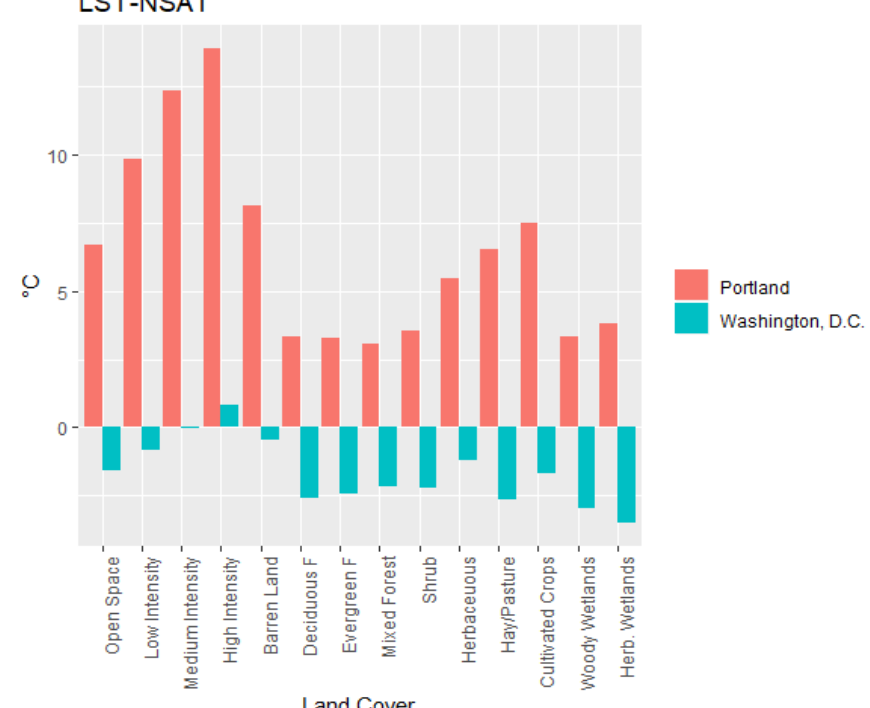
Figure 4. Temperature differences between LST and NSAT for Portland, Oregon and Washington, D.C. at each land